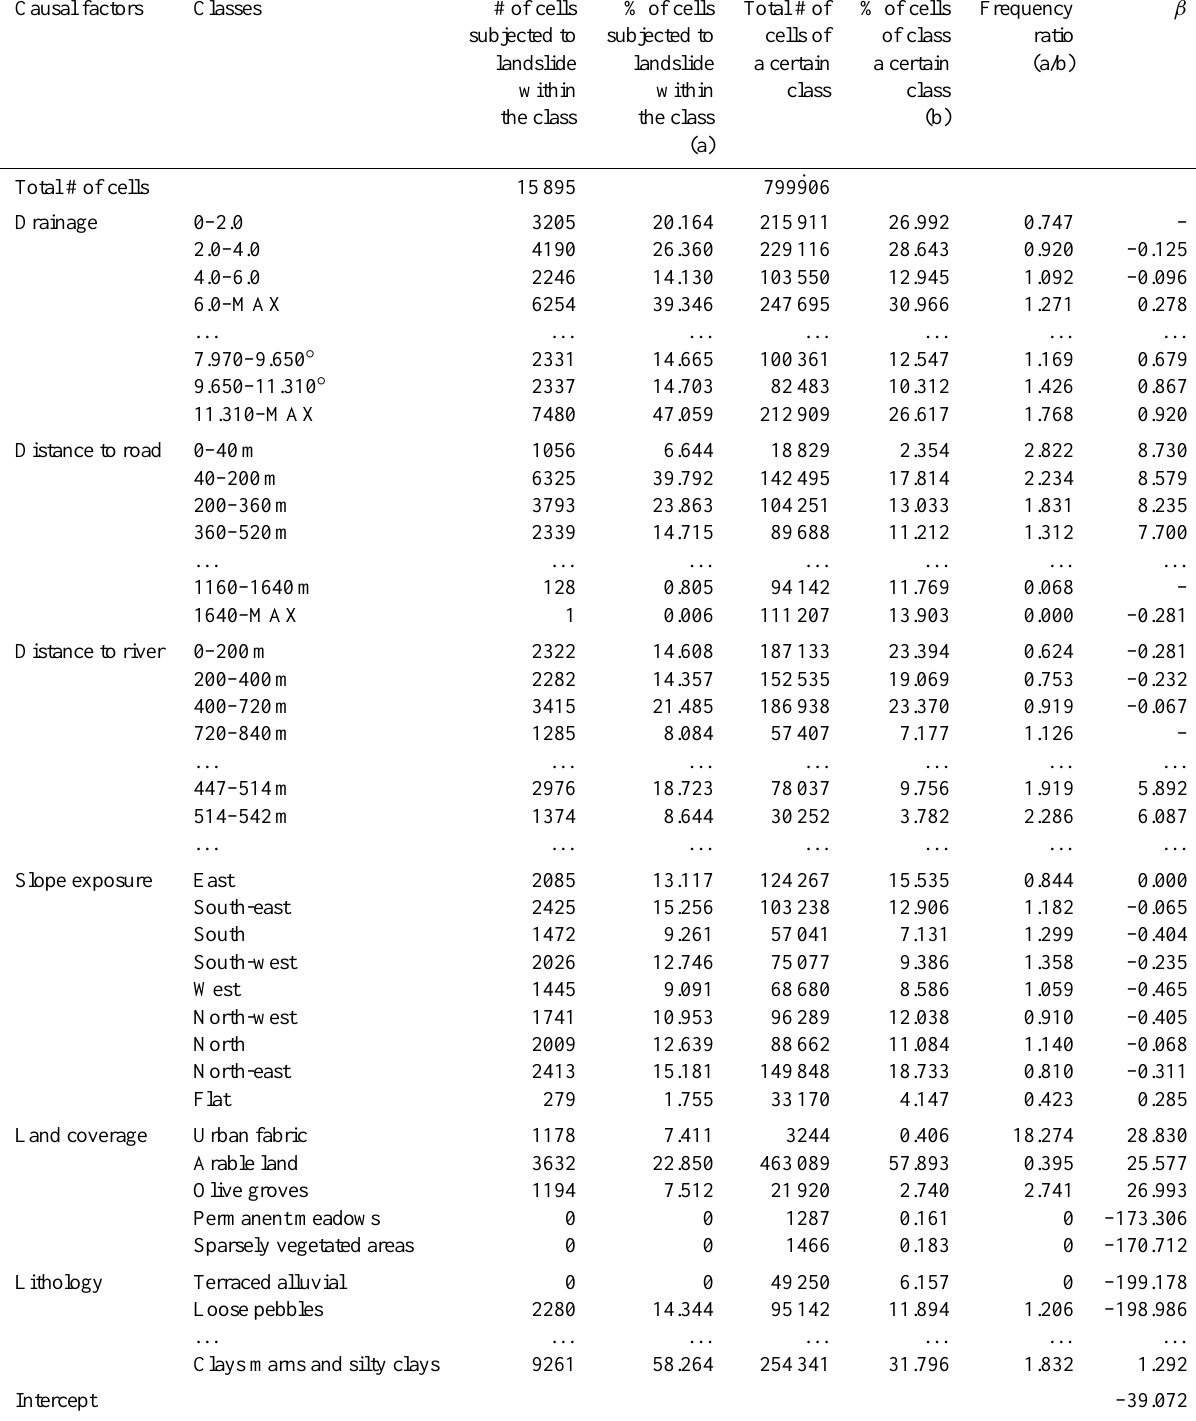
Table 3. Results provided by the LR analysis. Coefficients are related to each of the classes created for single causal factors. Causal